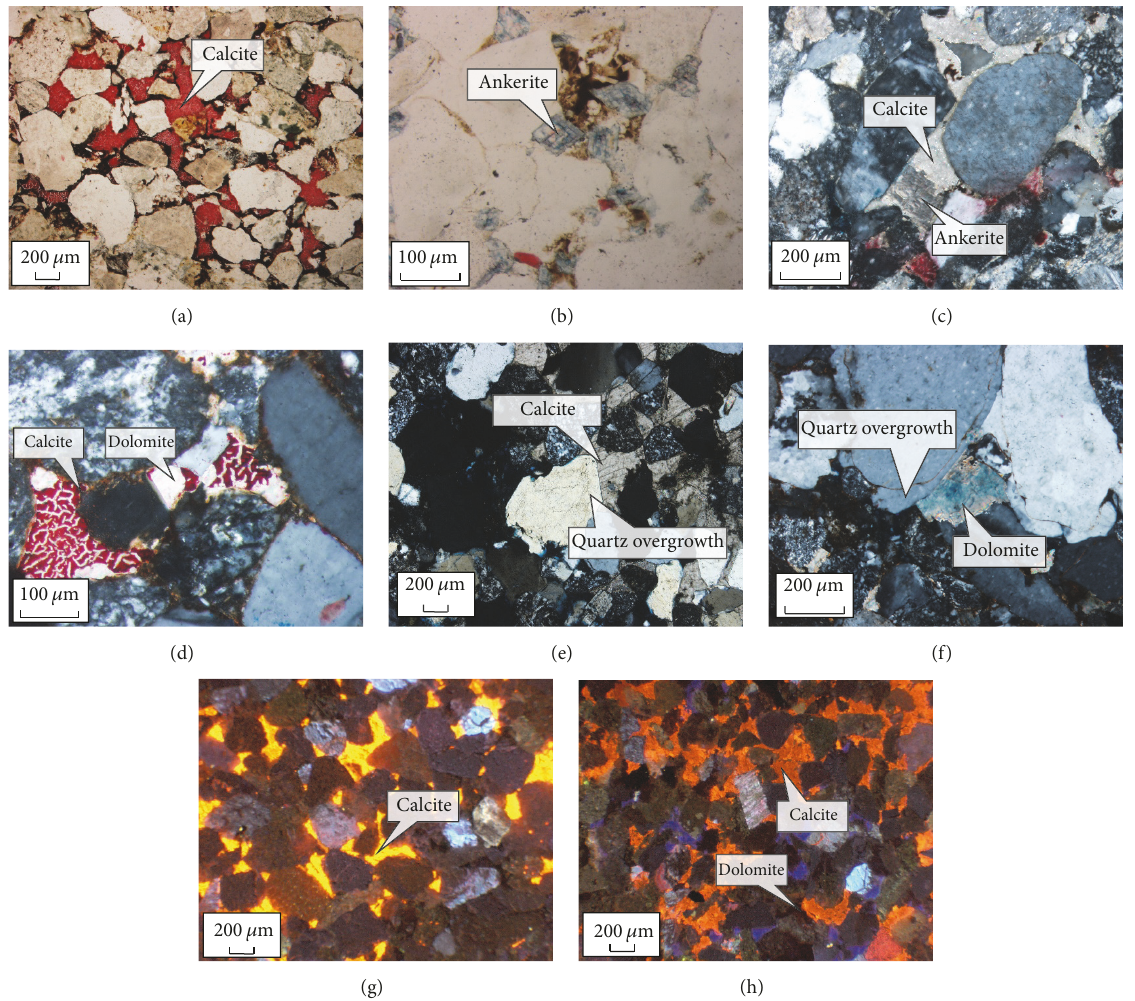
Figure 5: Photomicrographs showing petrographic features of the Xishanyao Formation sandstones. Most common types of mineralogy variations in sandstone cement, including (a) secondary pores were mainly filled by crystal calcite, major pores were filled by asphalt at the edges, and the photomicrograph is a stained red-epoxy-impregnated thin sections of conventional core samples by plane-polarized light with magnification of 40 (Y6 well at 6,048.59 m); (b) single-crystal rhombus ankerite, the photomicrograph is a stained blue-epoxy-impregnated thin sections of conventional core samples by plane-polarized light with magnification of 200 (Y6 well at 6028.52 m); (c) a few ankerites replace calcites in a red-epoxy-impregnated thin sections of conventional core samples with cross-polarized light with magnification of 100 (Y2 well at 5966.02 m); and (d) a few dolomites replace calcites in a stained red-epoxy-impregnated thin sections of conventional core samples with cross0polarized light with magnification of 200 (Y2 well at 5967.02 m); (e) crystal calcite filled in pores, and crystal postdate quartz overgrowth in a stained blue-epoxy-impregnated thin sections of conventional core samples by cross-polarized light with magnification of 40 (Y1 well at 5876 m); (f) dolomites develop in a stained blue-epoxy-impregnated thin sections of conventional core samples by plane- polarized light with magnification of 100 (Y2 well at 6000.25 m); (g) calcite cements show bright yellow luminescence in cathodoluminescence photomicrograph with magnification of 40 (Y7 well at 6095 m); (h) calcite cements show saffron luminescence and dolomites cements are disphotic in cathodoluminescence photomicrograph with magnification of 40 (Y8 well at 6099.46